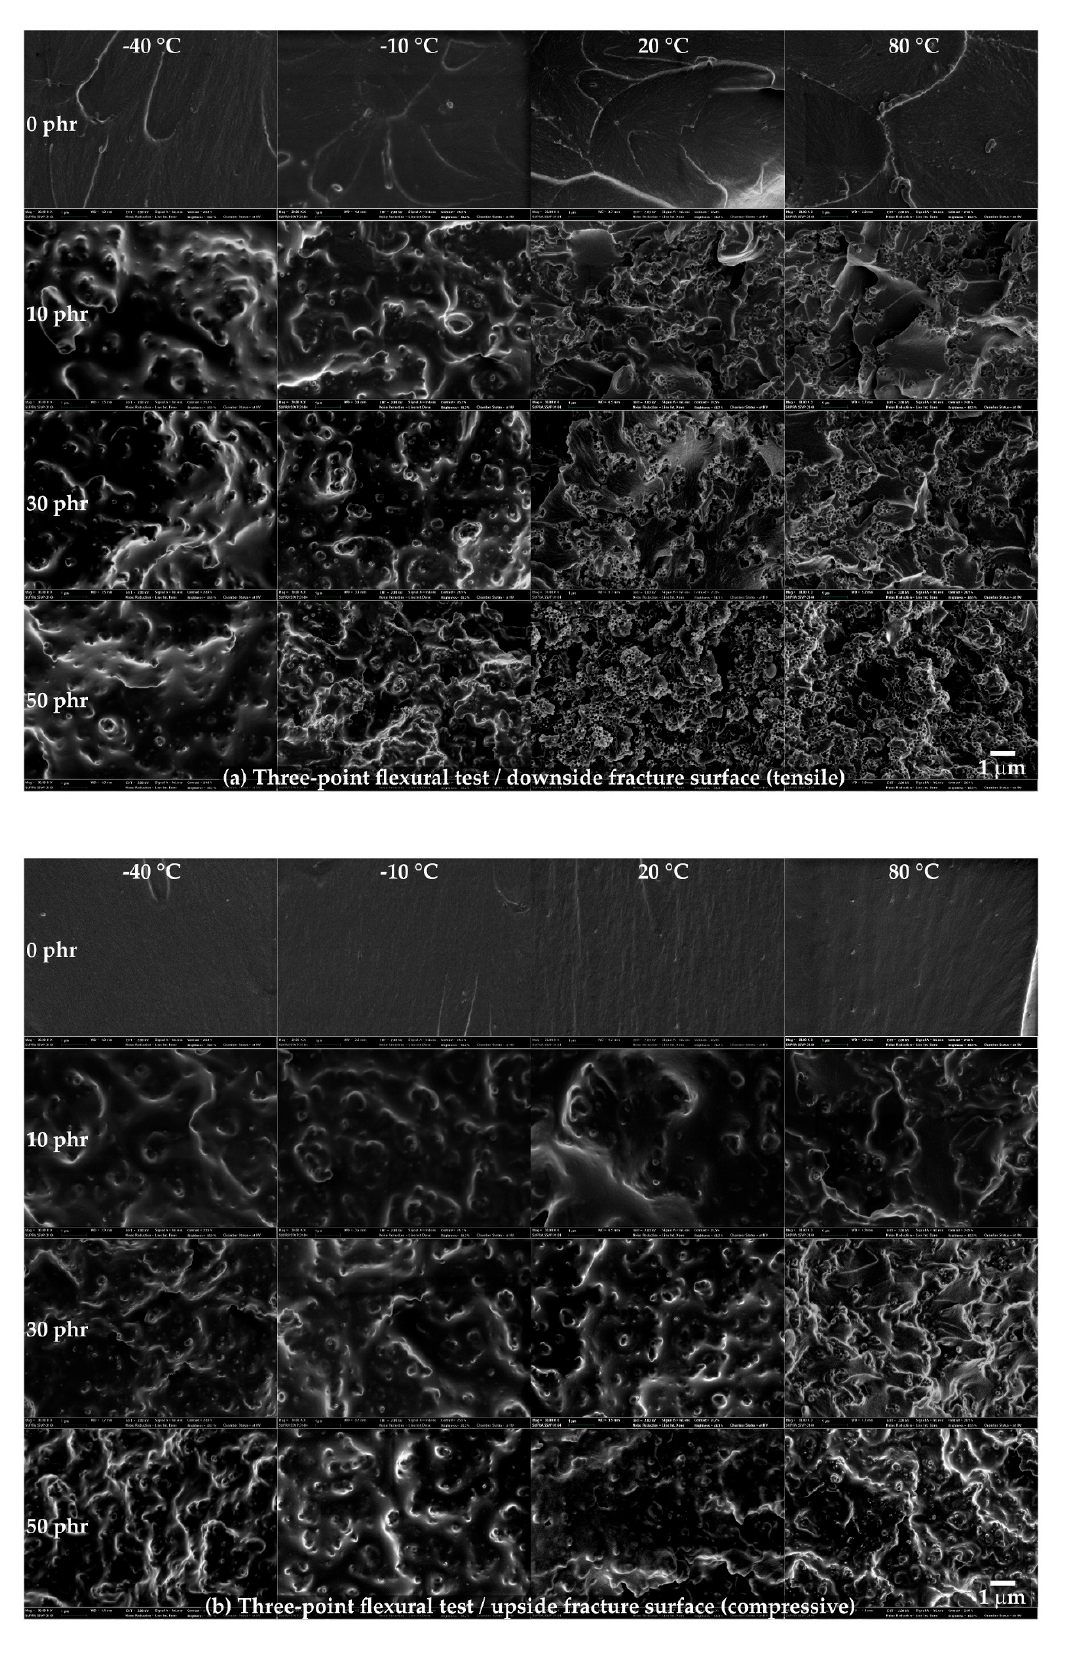
Figure 7. Field emission scanning electron microscopy (FE-SEM) images of the fracture surface in the three-point flexural tests.